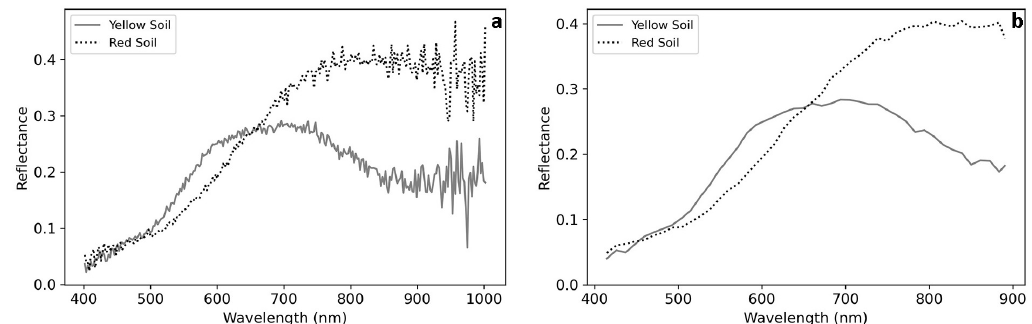
Figure 4. ( a ) Raw spectral profiles of yellow and red soils on Transect 2 from the 271 band Nano VNIR Hyperspec camera. ( b ) Spectral profiles of the same yellow and red soils on Transect 2 post spectral averaging to 45